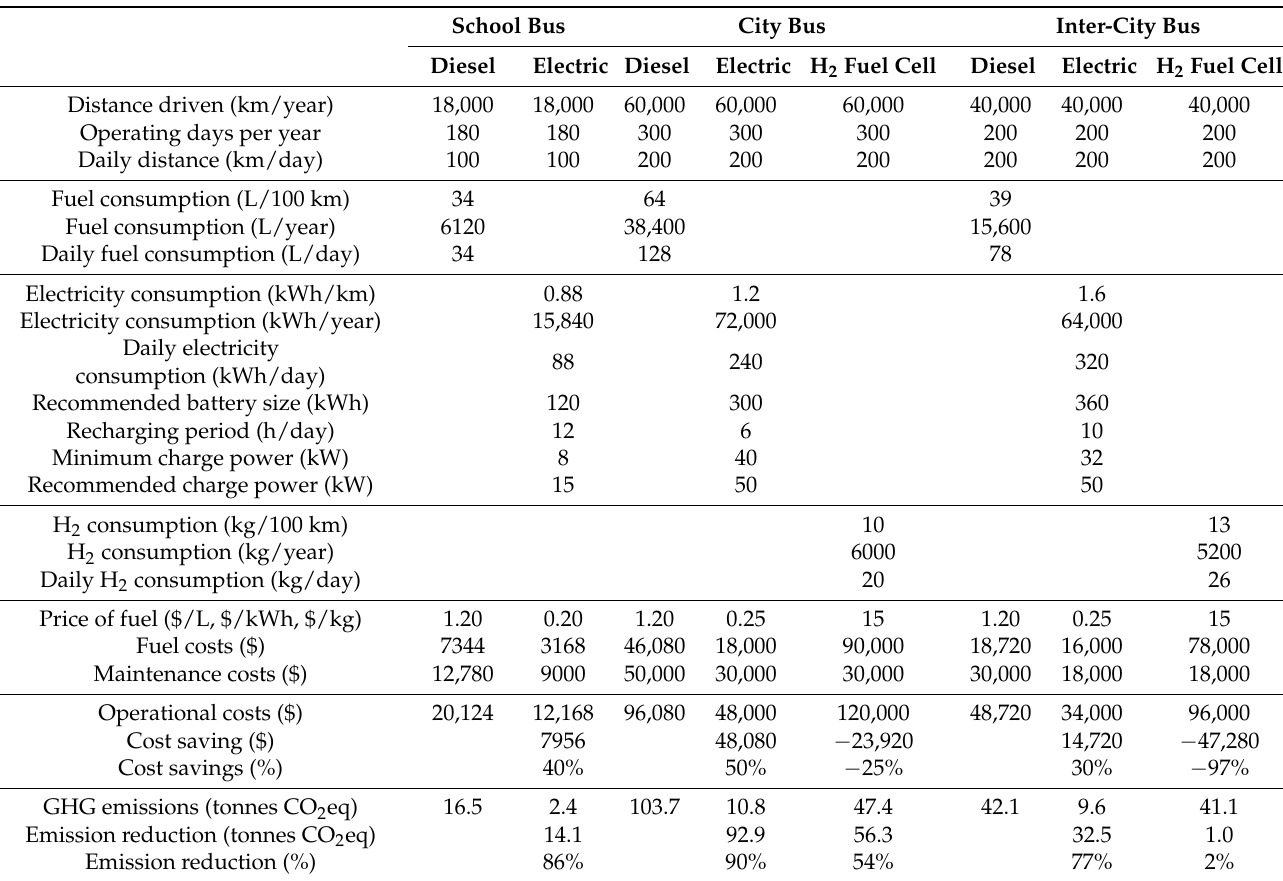
Table 5. Annual results (if not specified differently) for diesel, battery electric and hydrogen fuel cell buses (per